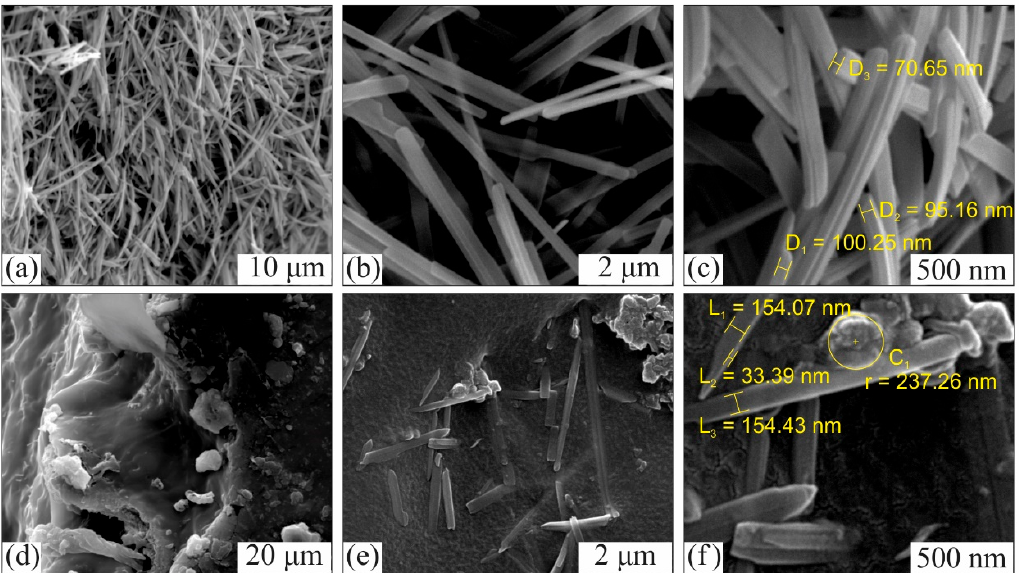
Figure 4. SEM images: ( a – c ) MoO 3 nanobelts; ( d ) cross section of PPy/SIS blend; ( e , f ) MoO 3 nanobelts incorporated in the PPy and SIS matrix forming nanocomposites.